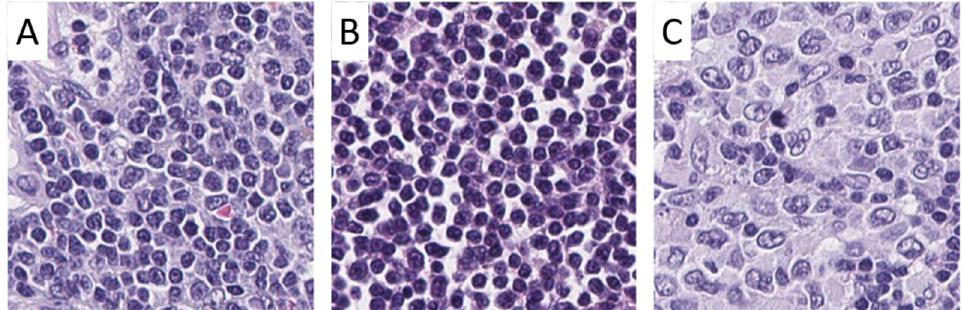
Figure 2. Examples of image patches from annotated areas. Representative image patches from control lymph nodes ( A ), small lymphocytic lymphoma/chronic lymphocytic leukemia ( B ), and diffuse large B-cell lymphoma ( C ) are shown. Mag- nification: each image 100 × 100 µm (395 × 395 px).